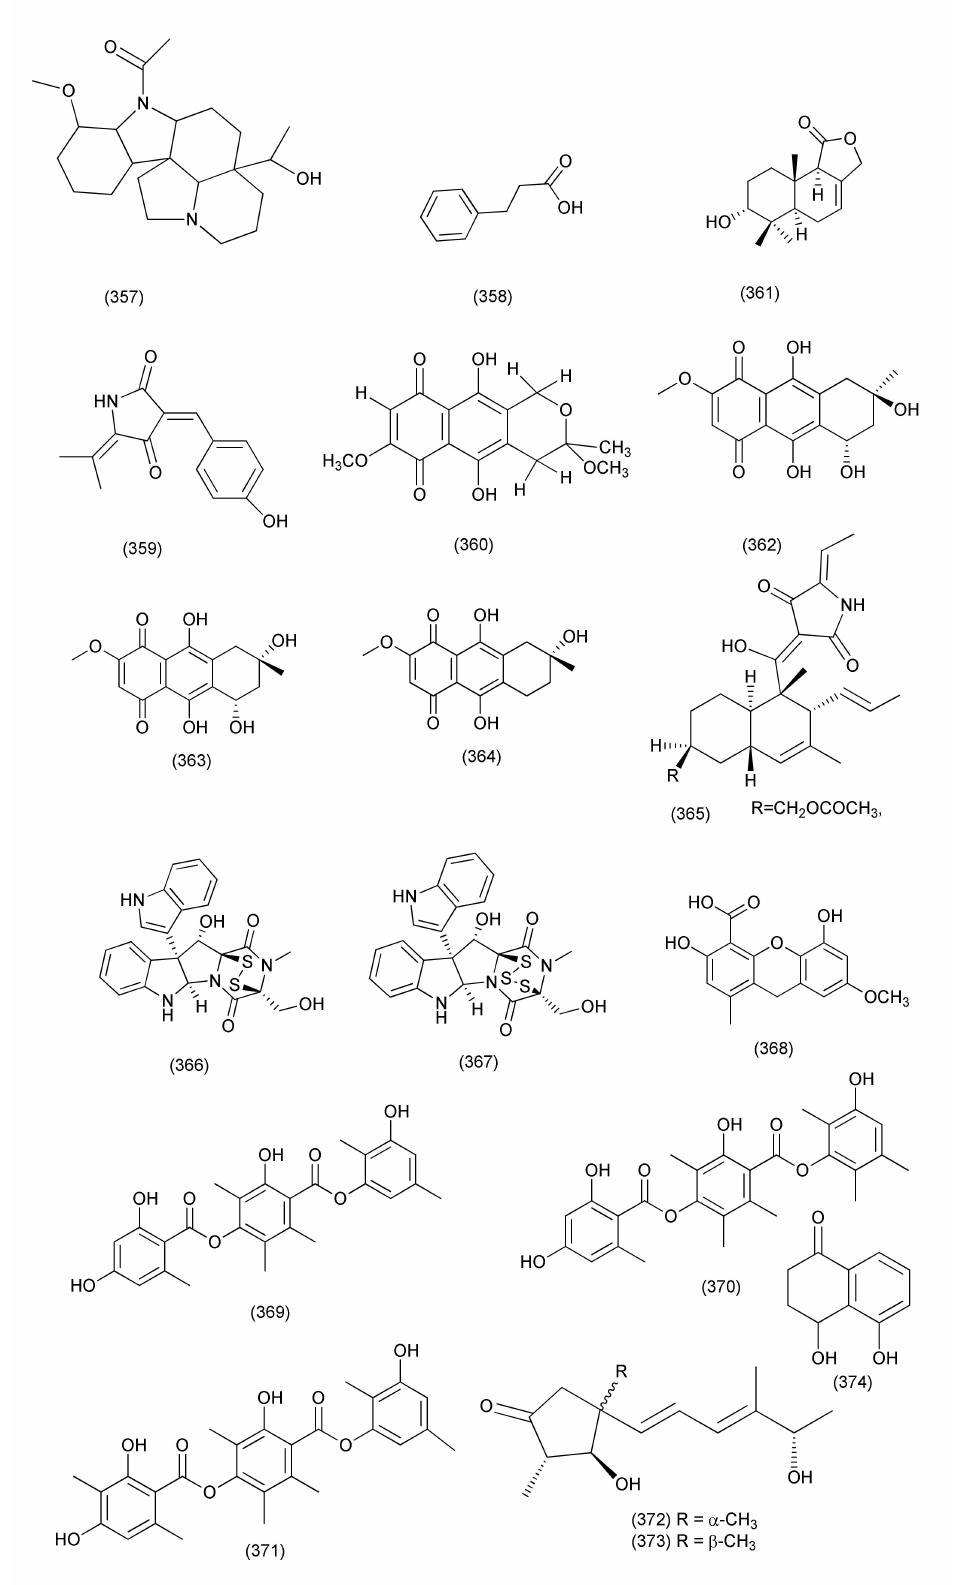
Figure 20. Structures of metabolites 357 – 374 isolated from Anamorphic